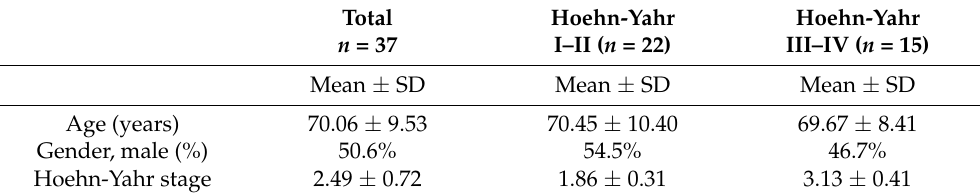
Table 1. Sociodemographic and clinical characteristics of the participants.